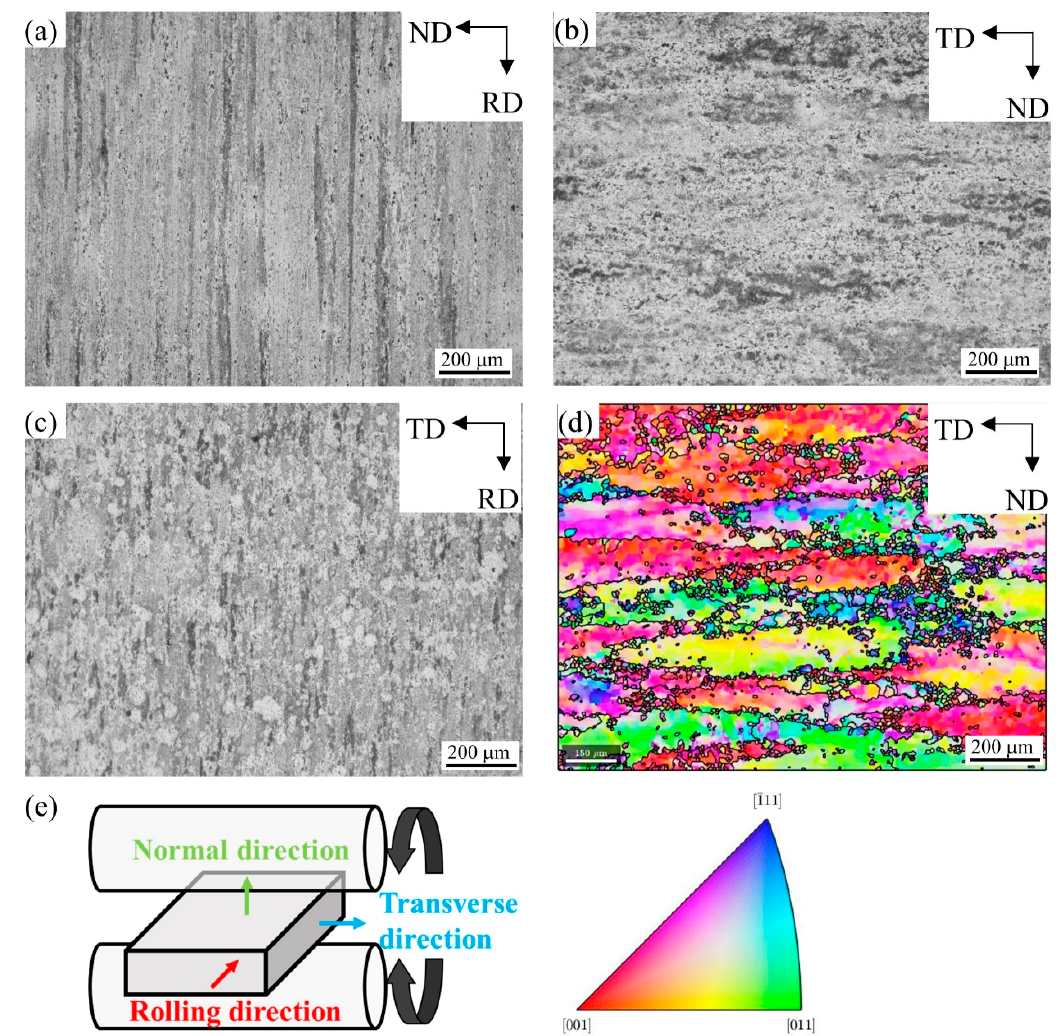
Figure 3. Microstructure of the raw hot-rolled 2A14 Al alloy on ( a ) the ND-RD plane, ( b ) the TD- ND plane, and ( c ) the TD-RD plane; ( d ) EBSD-IPF image of raw material on the TD-ND plane; ( e ) schematic diagram of the hot-rolled plate